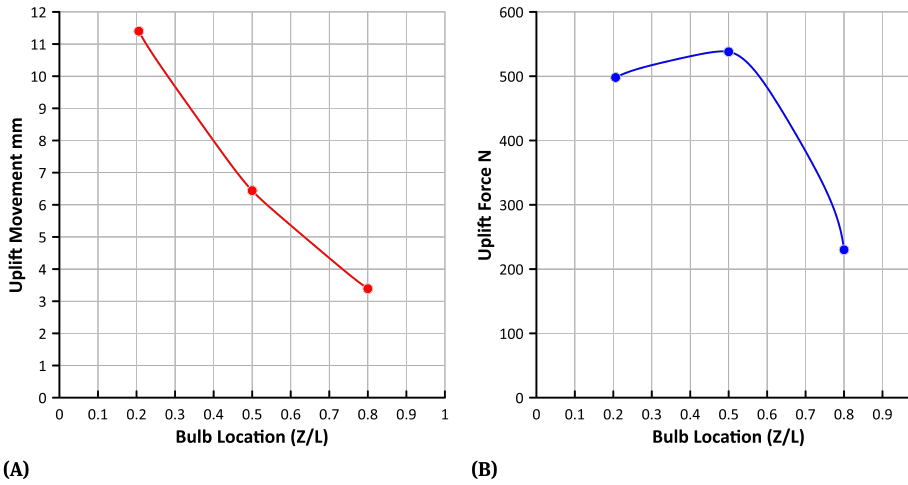
Figure 9: Relation between bulb location and (A) Uplift movement (B) Uplift force